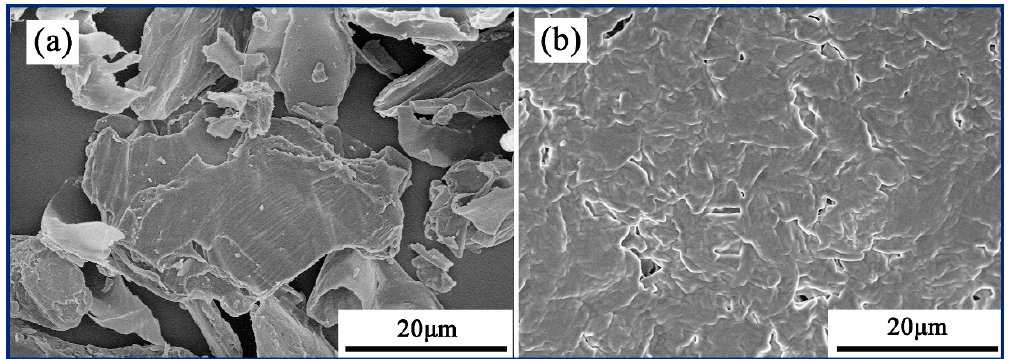
Figure 6. SEM images of ( a ) peanut shells and ( b ) liquefaction residue .